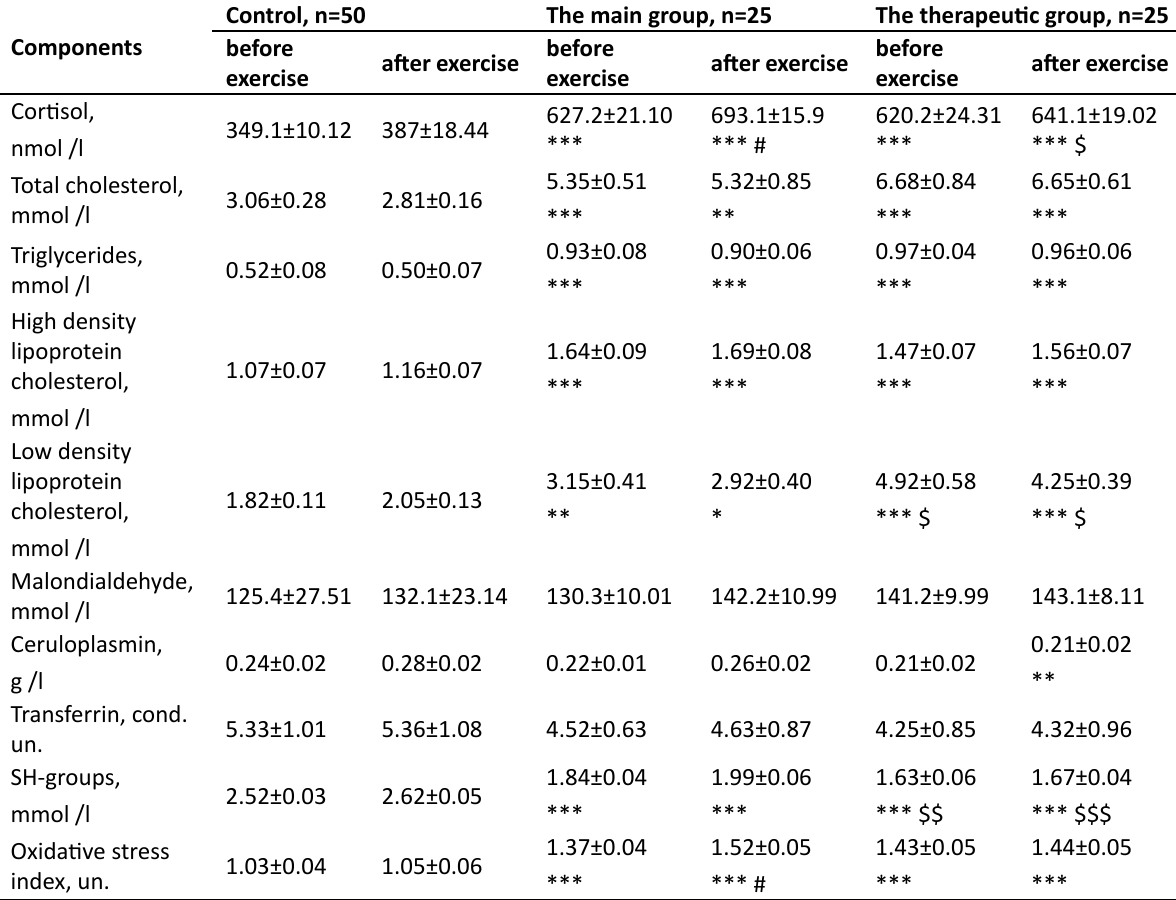
Table 1. Physical activity influence caused by physical training lessons on cortisol parameters, lipid profile and oxidative- antioxidant status of the examined (M ± m)